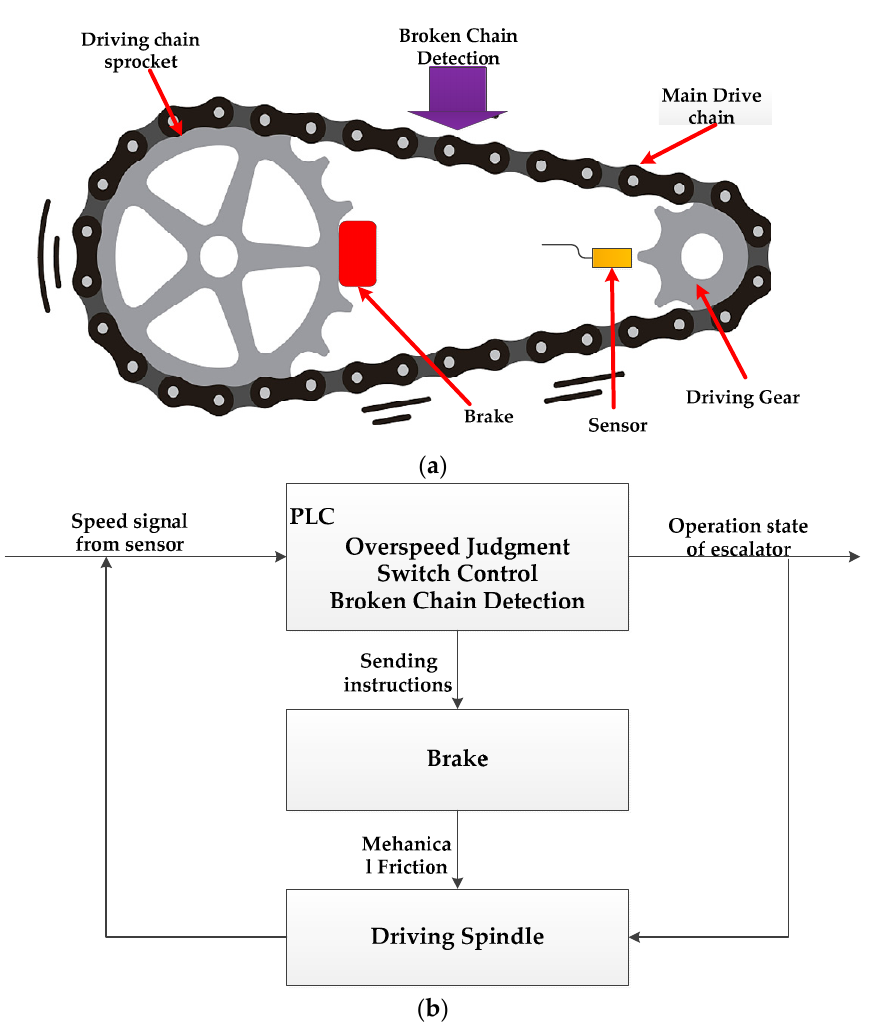
Figure 12. Structure diagram of EEBS: ( a ) Mechanical structure of drive chain protection device, ( b ) Working principle of the brake.